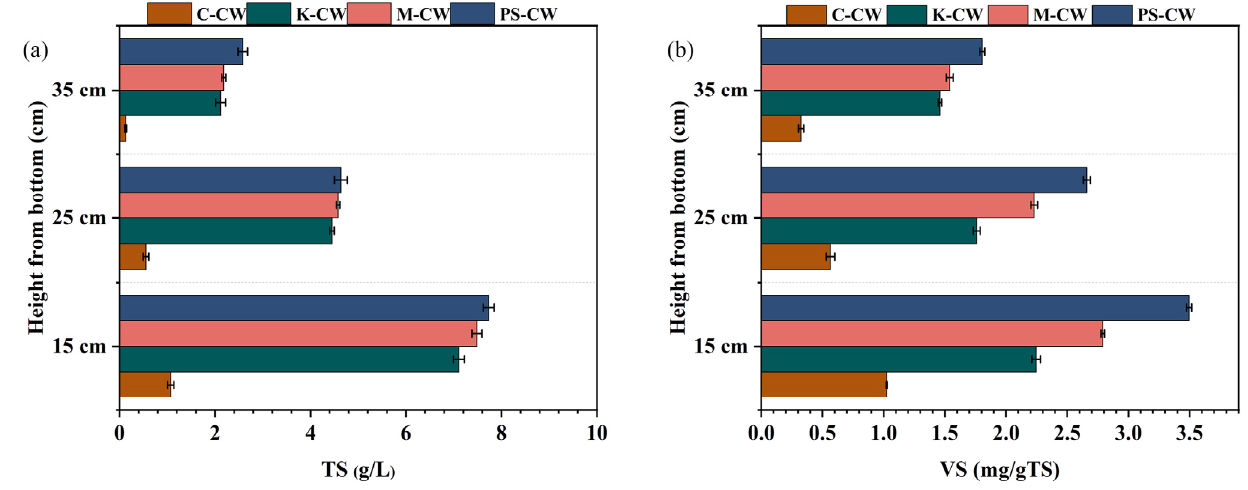
Figure 5. ( a ) Total solids (TS) and ( b ) volatile solids (VS) in C–CW, K–CW, M–CW and PS–CW.